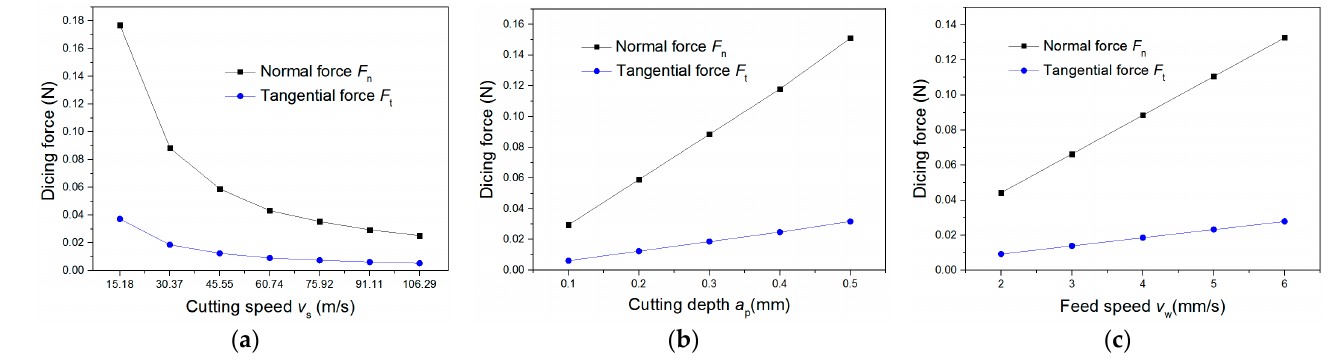
Figure 5. Variation of dicing force with ( a ) cutting speed v s ; ( b ) cutting depth a p ; ( c ) feed speed v w .